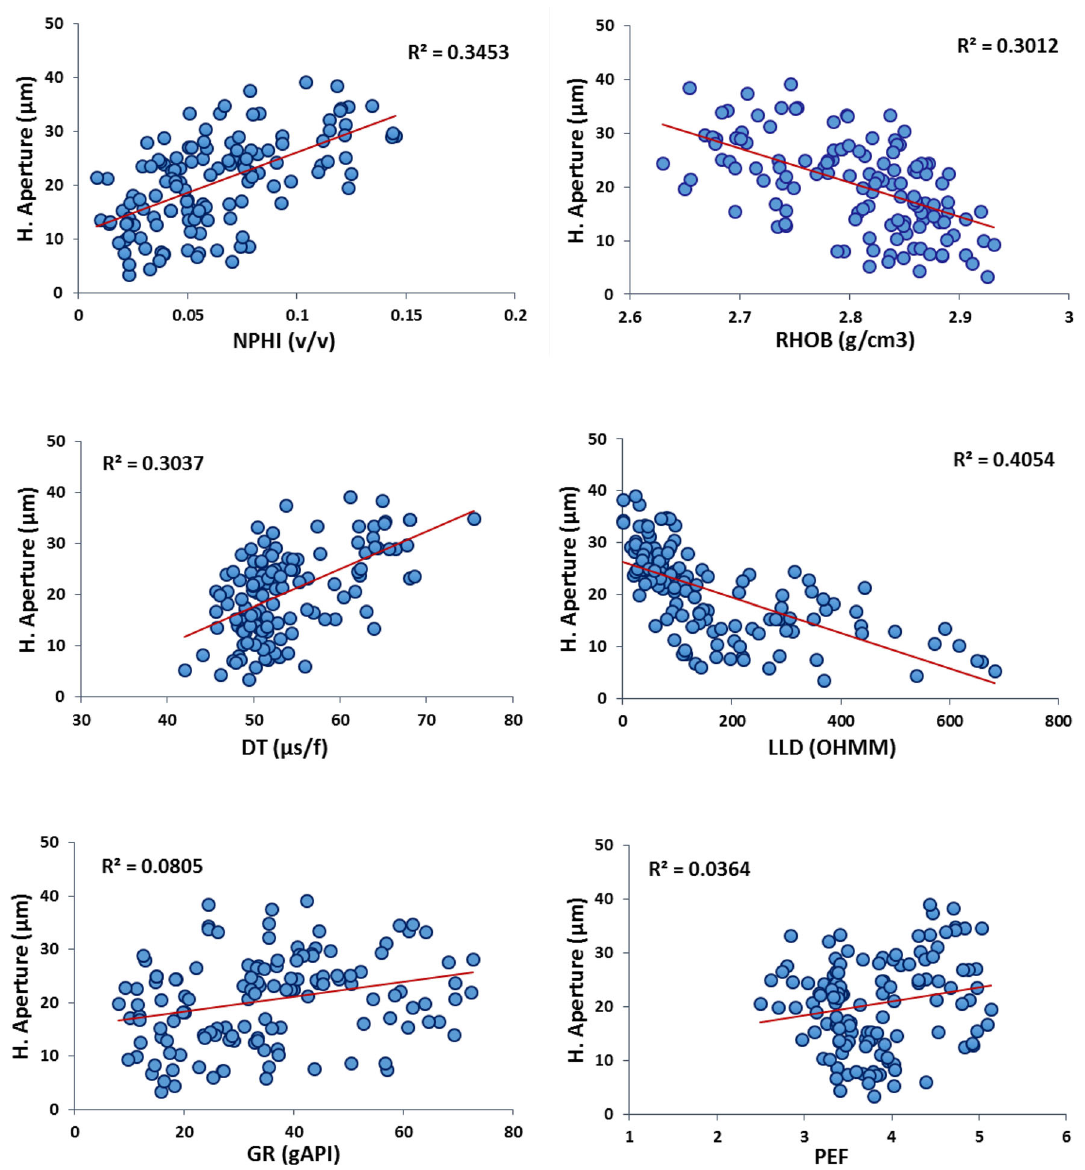
Fig. 5 Cross-plots of well logs responses versus the measured hydraulic aperture (H. Aperture) for detected fractures in the studied wells. R 2 indicates the coefficient of